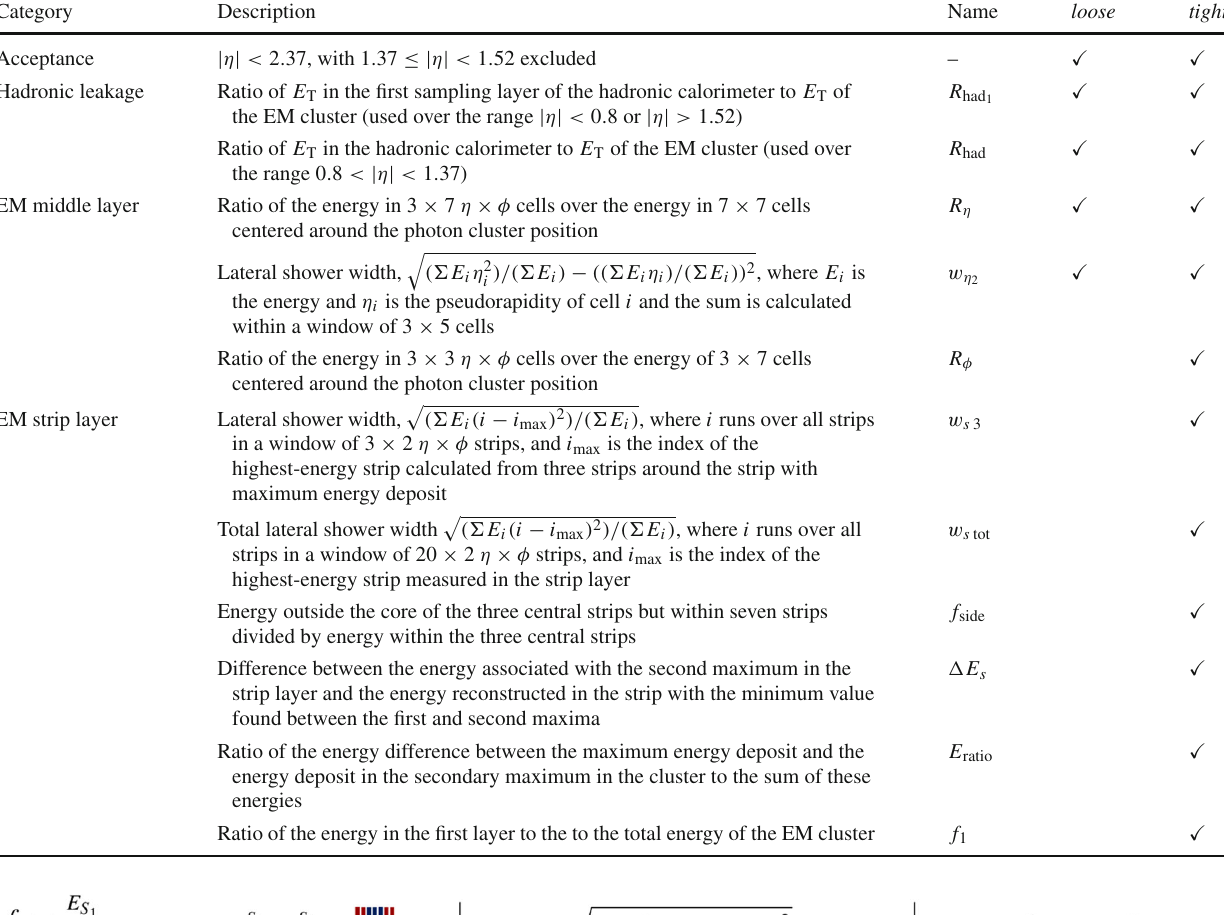
Table 1 Discriminating variables used for loose and tight photon identification Category Description Name loose tight Acceptance Hadronic leakage